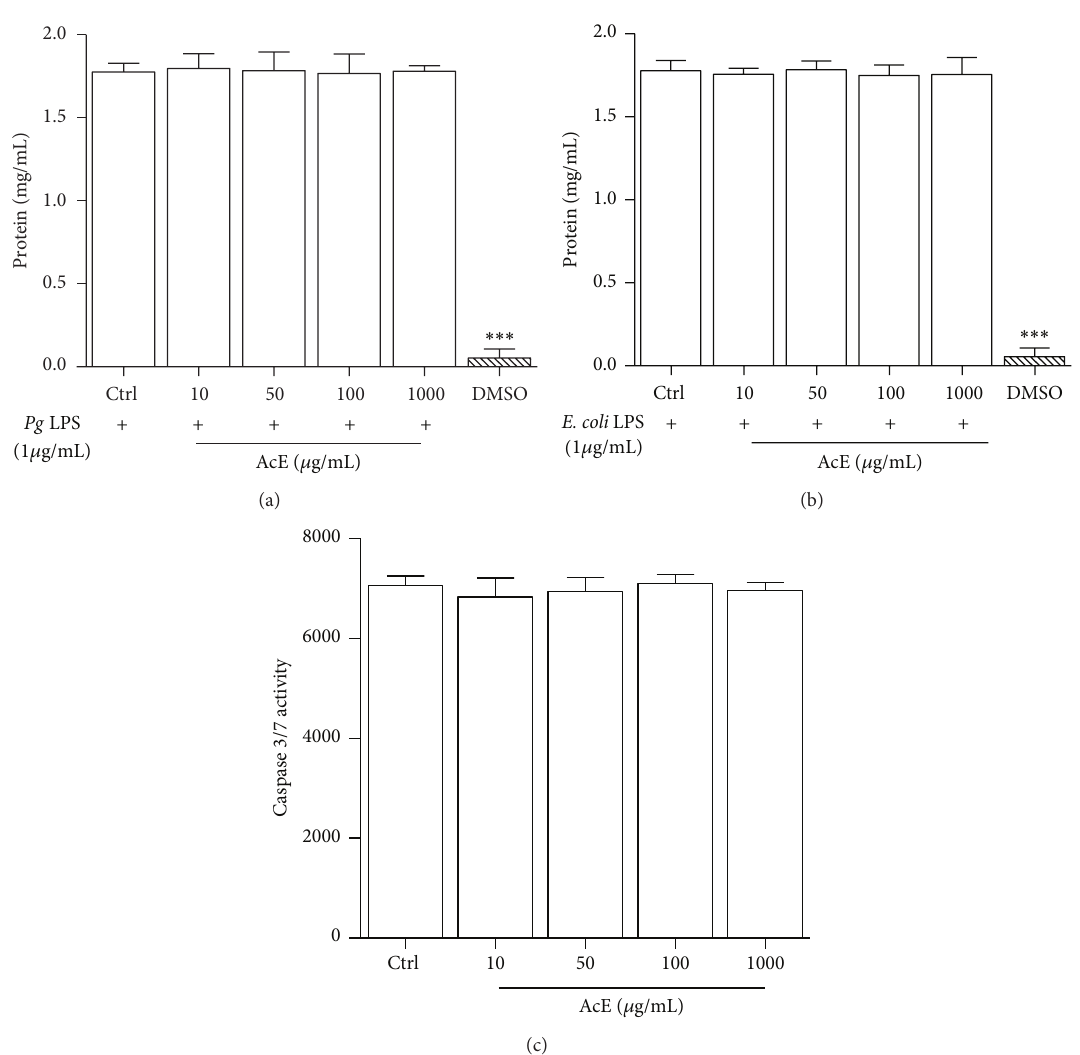
Figure 3: Effect of Allium cepa L. on total protein levels of LPS-induced and apoptosis in RAW 264.7 cells. In (a) and (b), cells were cultured in the presence of Pg LPS (a) and E. coli LPS (b), and AcE; untreated cells (Ctrl) were not exposed to AcE. DMSO was used for positive control. After 5 days of continuous exposure, quantification of total protein levels was assessed using protein assays. In (c), activities of caspase-3 and caspase-7 were examined by caspase 3/7 assay. In (a), (b), and (c) columns represent the mean values of the results obtained of three independent experiments, and error bars represent the standard error from the means. There was no significance between control (Ctrl) and cells in all concentrations tested,